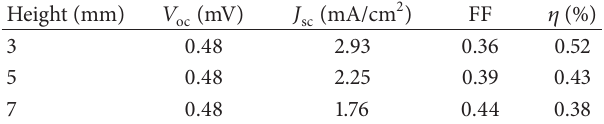
Table 4: Photovoltaic parameters of the 3D DSSC made at different cell heights with a carbon counter